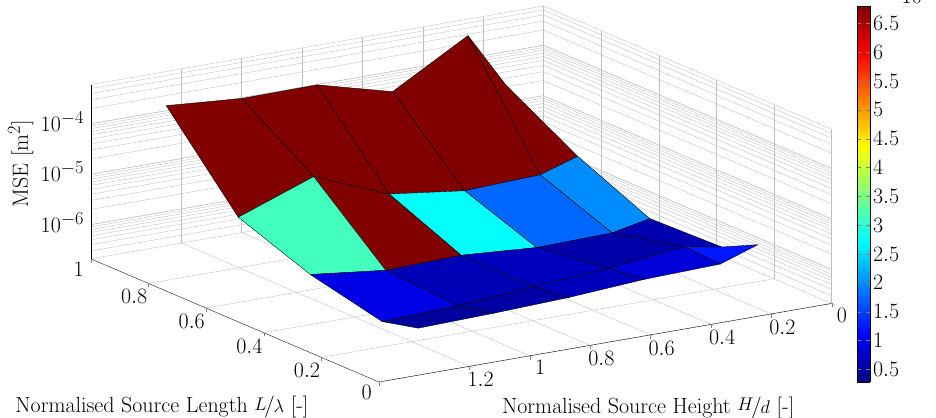
Figure 8. Intermediate water case. Source centre at d of 1.25 d and source length 1